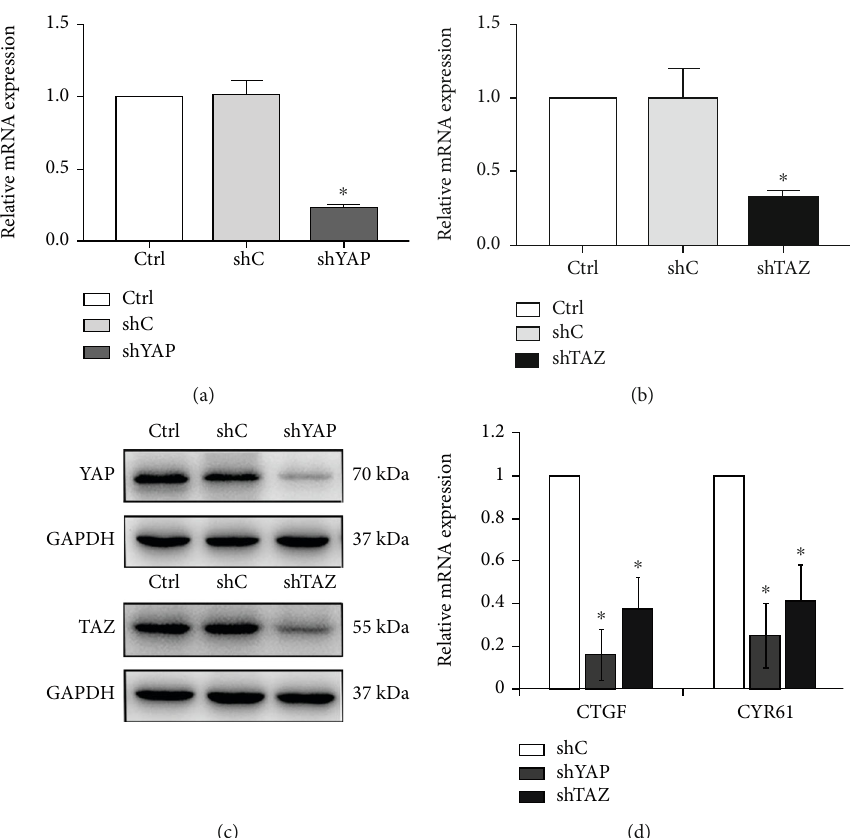
Figure 2: Knockdown of YAP and TAZ in the lentiviral-transduced RA-FLS. (a, b) YAP and TAZ mRNA levels were evaluated from RA-FLS stably expressing shRNA speci fi c for YAP (shYAP), TAZ (shTAZ), the corresponding vector control (shC), and null (Ctrl) using RT-qPCR and normalized against GAPDH. Data are the mean ± SD ( n = 4 ). ∗ P < 0 : 05 relative to shC by Student ’ s t -test. (c) Knockout of YAP and TAZ was con fi rmed by western blot analysis in RA-FLS, and GAPDH served as a loading control. Representative blots are shown ( n = 3 ). (d) Quantitative analysis of CTGF and CYR61 mRNA in stable YAP and TAZ knockdown RA-FLS by RT-qPCR and normalized against GAPDH. Data were shown as the mean ± SD ( n = 4 ). ∗ P < 0 : 05 relative to shC by Student ’ s t